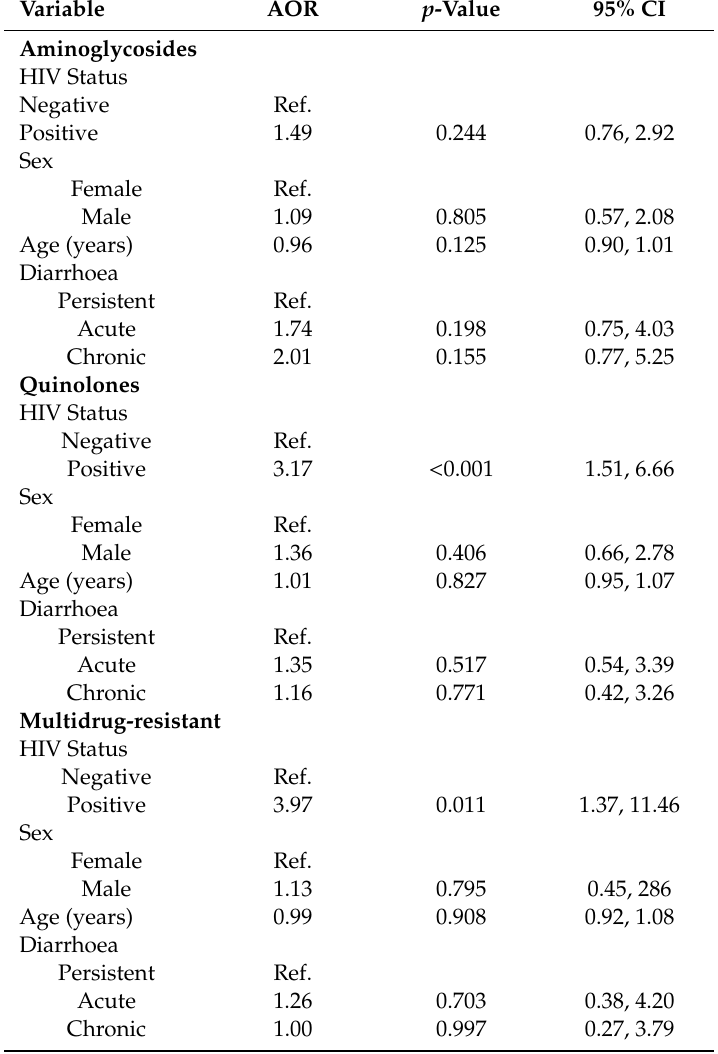
Table 3. Multiple Logistic Regression Models of resistance to the family of antimicrobials.